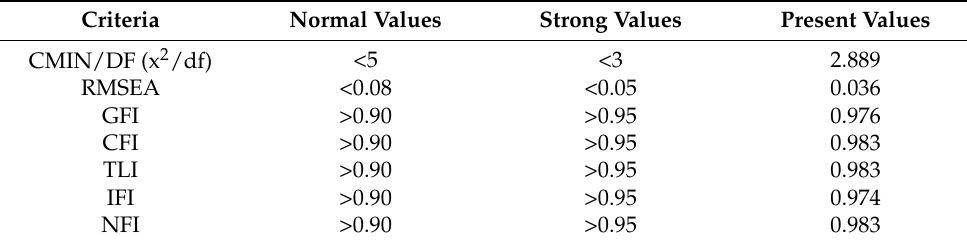
Table 1. Confirmatory factor analysis